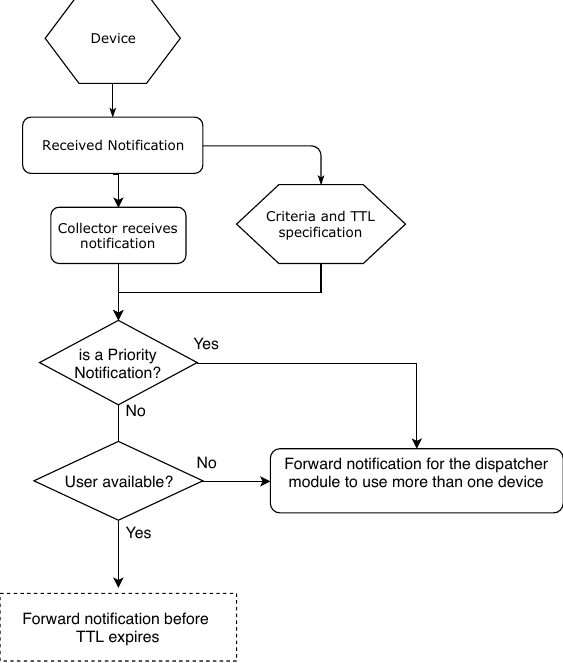
Figure 4. Flowchart